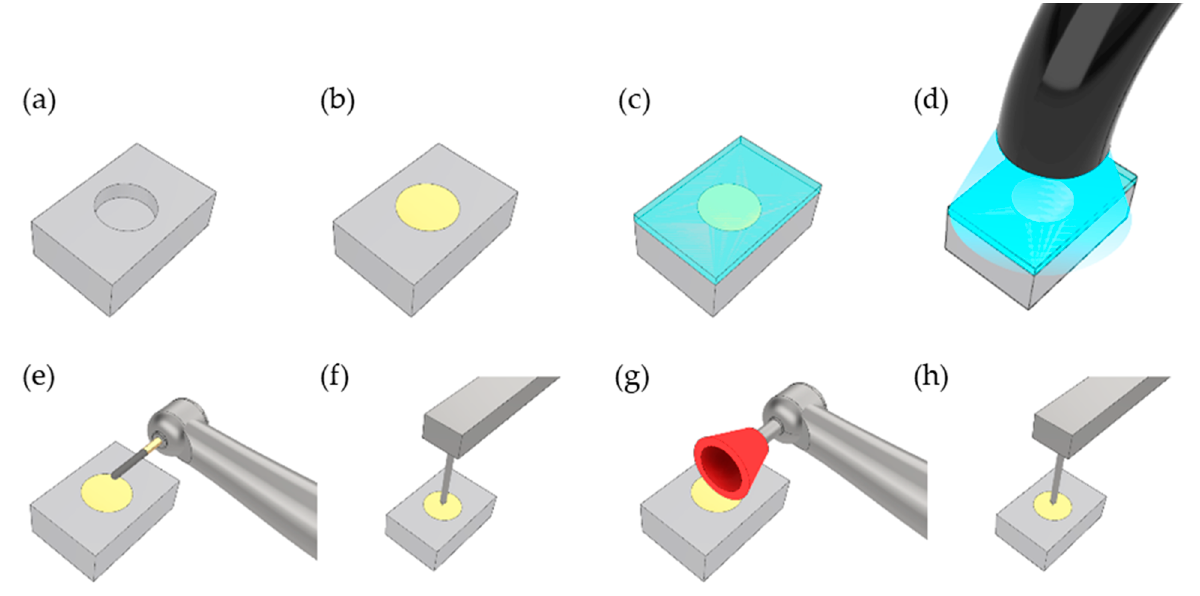
Figure 1. Specimen’s preparation. ( a ) Silicone index (6 mm in diameter; 2 mm in depth); ( b ) composite insertion inside the index; ( c ) glass blade pressed to create a flat surface; ( d ) light curing procedure; ( e ) surface finishing simulation; ( f ) baseline roughness measurement; ( g ) polishing procedure; ( h ) roughness measurement after polishing. Table 2. Specifications of the polishing systems tested. Material